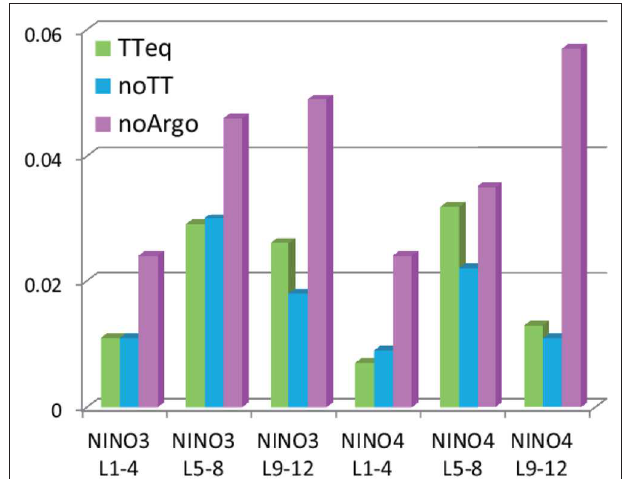
FIGURE 1 | Result of an OSE study evaluating the impacts of TAO/TRITON and Argo data in a seasonal forecasting system in JMA ( Fujii et al., 2015a). Compared to a control run this shows a decrease of the ACCs of SST averaged in the NINO3 (5 ◦ S-5 ◦ N, 90–150 ◦ W) and NINO4 (5 ◦ S-5 ◦ N, 150 ◦ W-160 ◦ E) regions in the hindcasts from OSEs with removal of TAO/TRITON data only within 2.5 ◦ S-2.5 ◦ N (TTeq), all TAO/TRITON data (noTT), and all Argo data (noArgo) for the lead-times of 1–4, 5–8, and 9–12 months (L1-4, L5-8, and L9-12, respectively). Hindcasts are started from the end of January, April, July, and October in 2004–2011 with 11 ensemble members. Forecast biases are estimated for each lead month and for each OSE separately, and removed from the forecasted